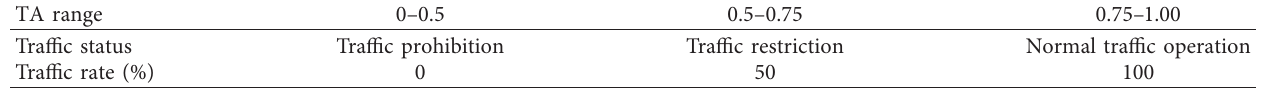
Table 4: Traffic control status of the bridge with respect to different TA ranges.